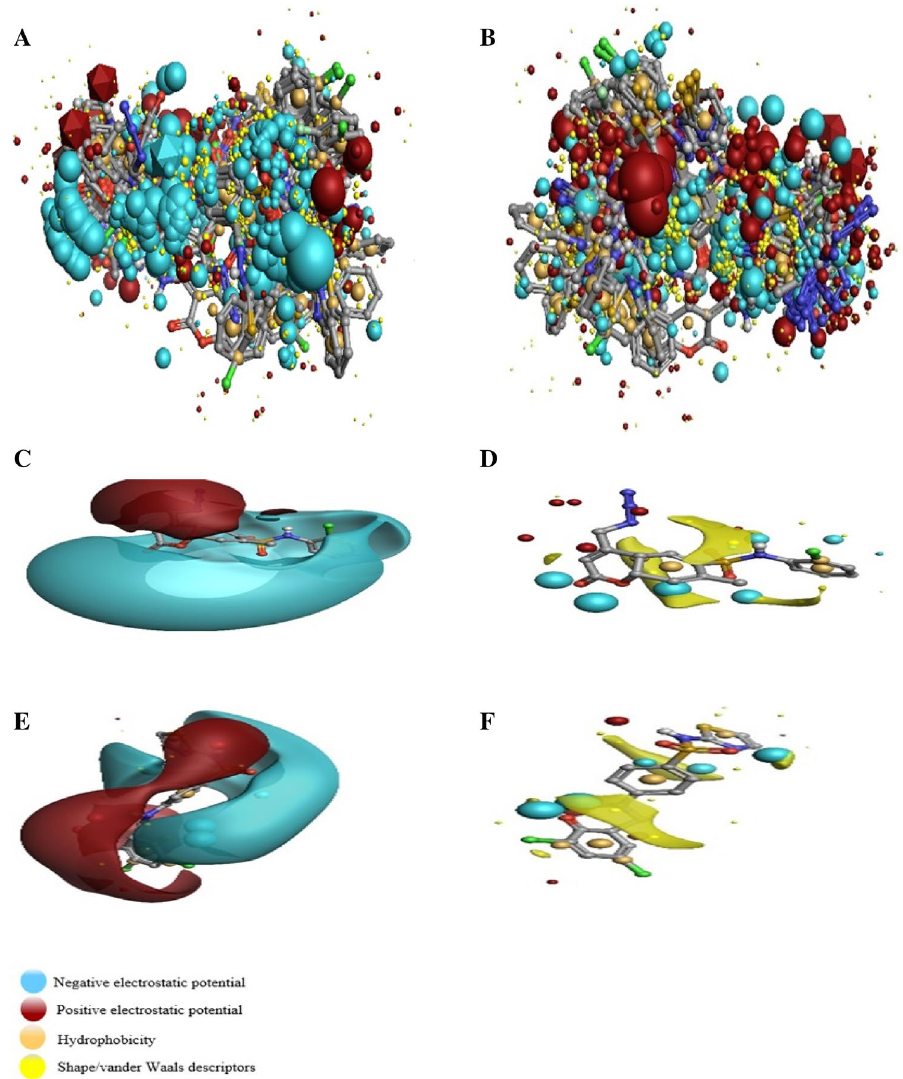
Figure 4. ( A , B ) The aligned training set compounds’ Molecular exhibition with regard to their field points. Molecular representation of high and low active training set compounds with respective biological activity (pMIC). ( C–F ) The molecular regions interacting with positive or H-bond donors of the target were to be presented by cyan color, which show negative field points. Positive field points were to be exhibited by red color that indicates possible molecular regions interacting with negative or H-bond acceptor of the target protein. Gold color indicates hydrophobic field points, which shows high polarizability or hydrophobicity areas, and yellow color presented Van der Waal field points. ( C ) and ( D ) belong to the S. aureus 3D-QSAR, ( E ) and ( F ) belong to the E. coli 3D-QSAR